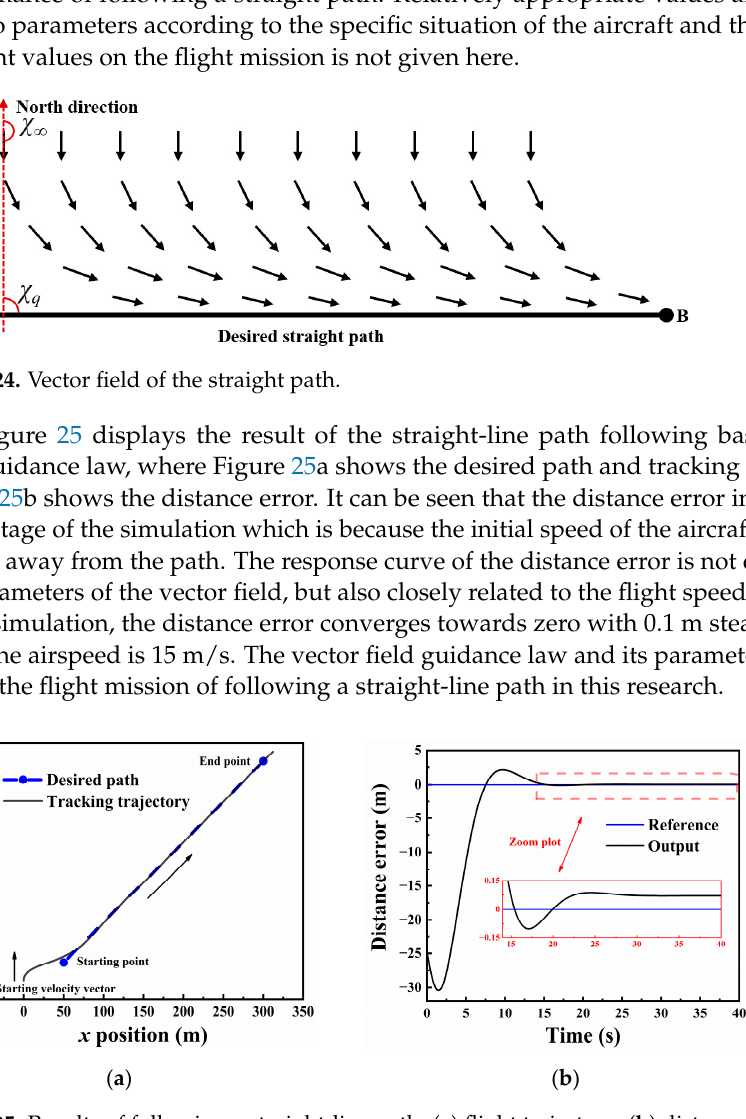
where φ orbit is the angle of the vector from the aircraft to the center of the circle relative to the north direction; λ is the turn direction, and λ = 1 signifies clockwise direction and λ = − 1 signi fi es counter-clockwise direction; k orbit is turning coefficient of following an orbit path; d is the distance from the aircraft to the center of the orbit path; r is the radius, r is selected as 100 m according to the flight task requirements in this paper. However, the application of the vector field guidance law to follow the circular tra- jectory has a large steady-state error in the simulation. This is because the desired course angle will change with the position of the aircraft when the aircraft follows an orbit path, and the response of the UAV to the course angle command has a certain delay, resulting in the UAV not being able to track the desired course angle in time. L 1 guidance law is implemented in this work to solve the problem, and specific details of L 1 guidance law